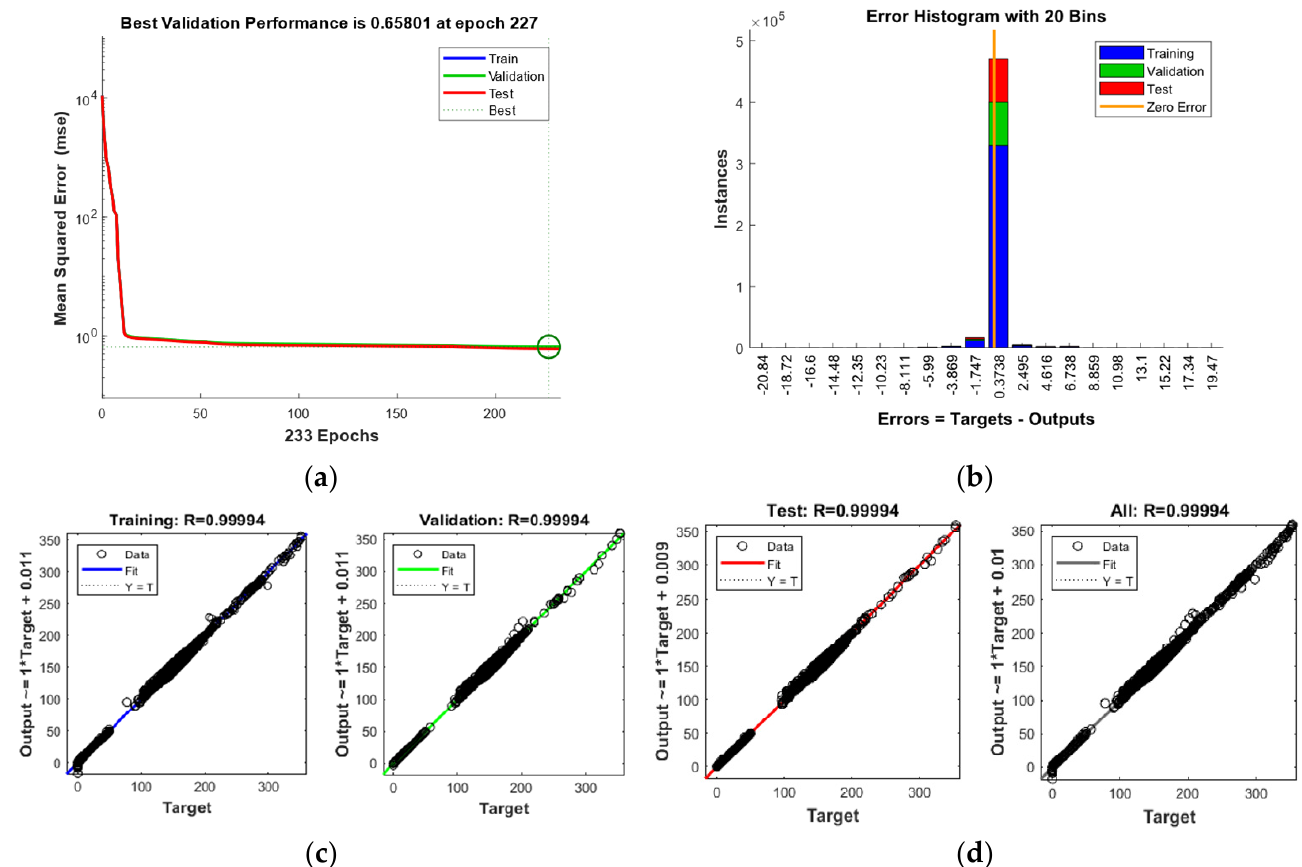
Figure 22. ( a ) Performance of the narx based electromagnetic torque M e estimator considering mean squared error (MSE); ( b ) Error histogram of electromagnetic torque M e ; ( c ) Regression between the narx estimated electromagnetic M e torque and the measured one in the Simulink IM drive during training andvalidation; ( d ) Regression during testing and regression globally calculated.